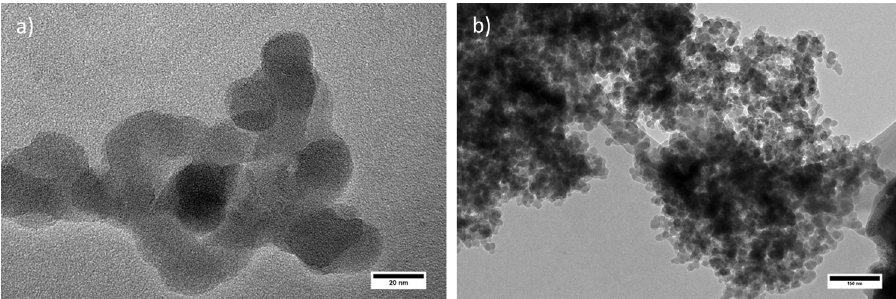
Figure 2: Selected TEM images for verifying SiO 2 particle size via ( a ) high magni fi cation assessing small particle agglomerations ( b ) overview picture using lower magni fi cation for particle size